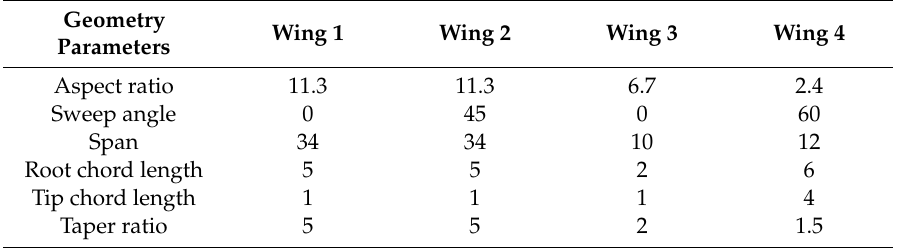
Table 1. Details of test wings used for grid convergence study.